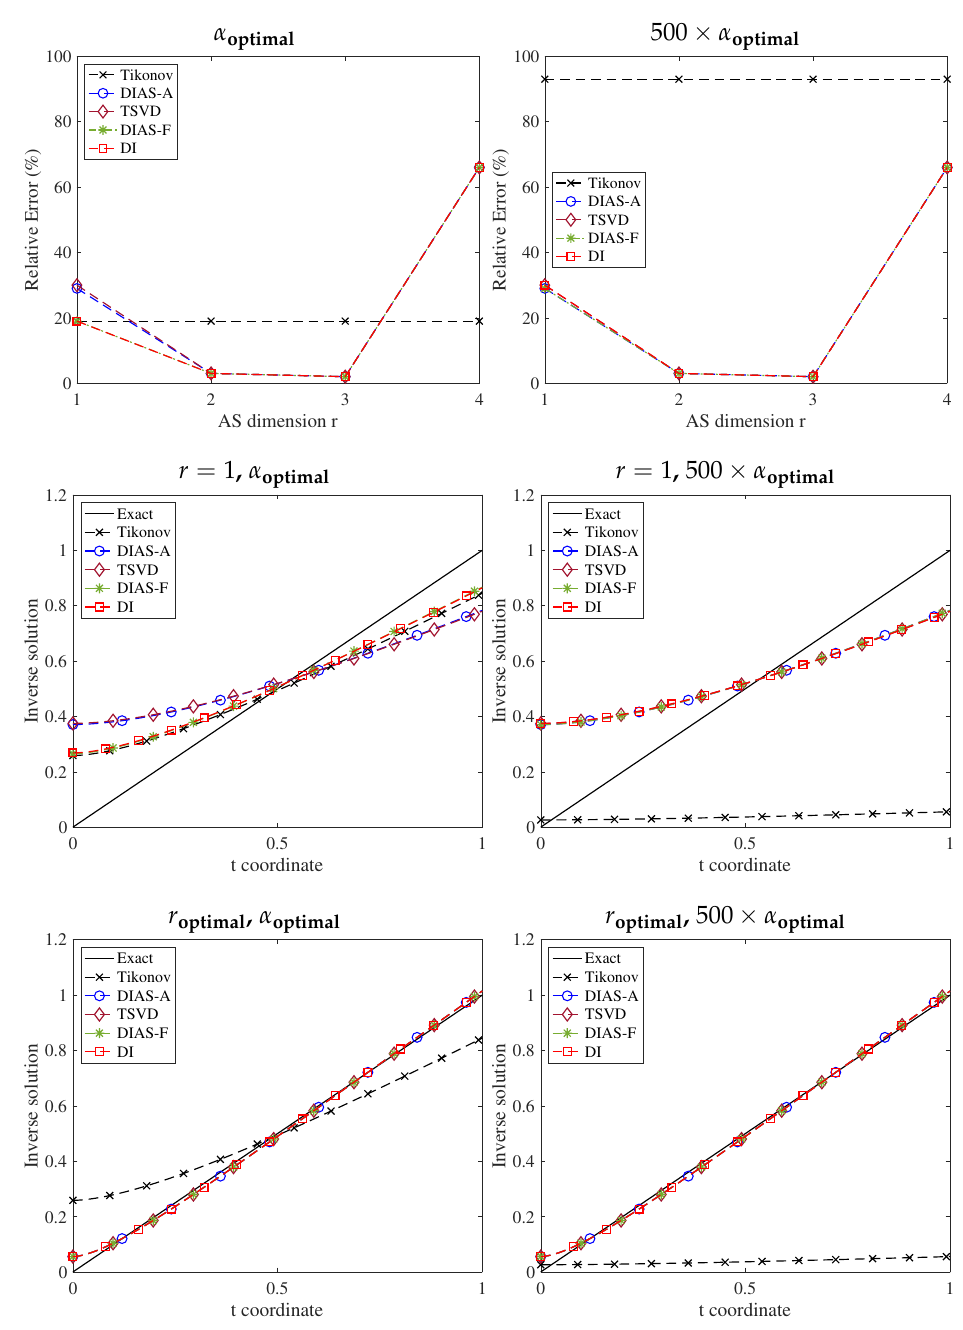
Figure 9. Foxgood, α optimal = 1.7 × 10 − 2 . Comparison of different DIAS regularizations and Tikhonov regularization. Top row: relative errors in the inverse solutions for different regularization methods for two values of regularization parameter. Middle row: inverse solutions with DIAS regularizations with one-dimensional active subspace and Tikhonov regularization for two values of regularization parameter. Bottom row: inverse solutions with DIAS regularizations with the optimal dimension active subspace ( r optimal = 3) and Tikhonov regularization for two values of regularization